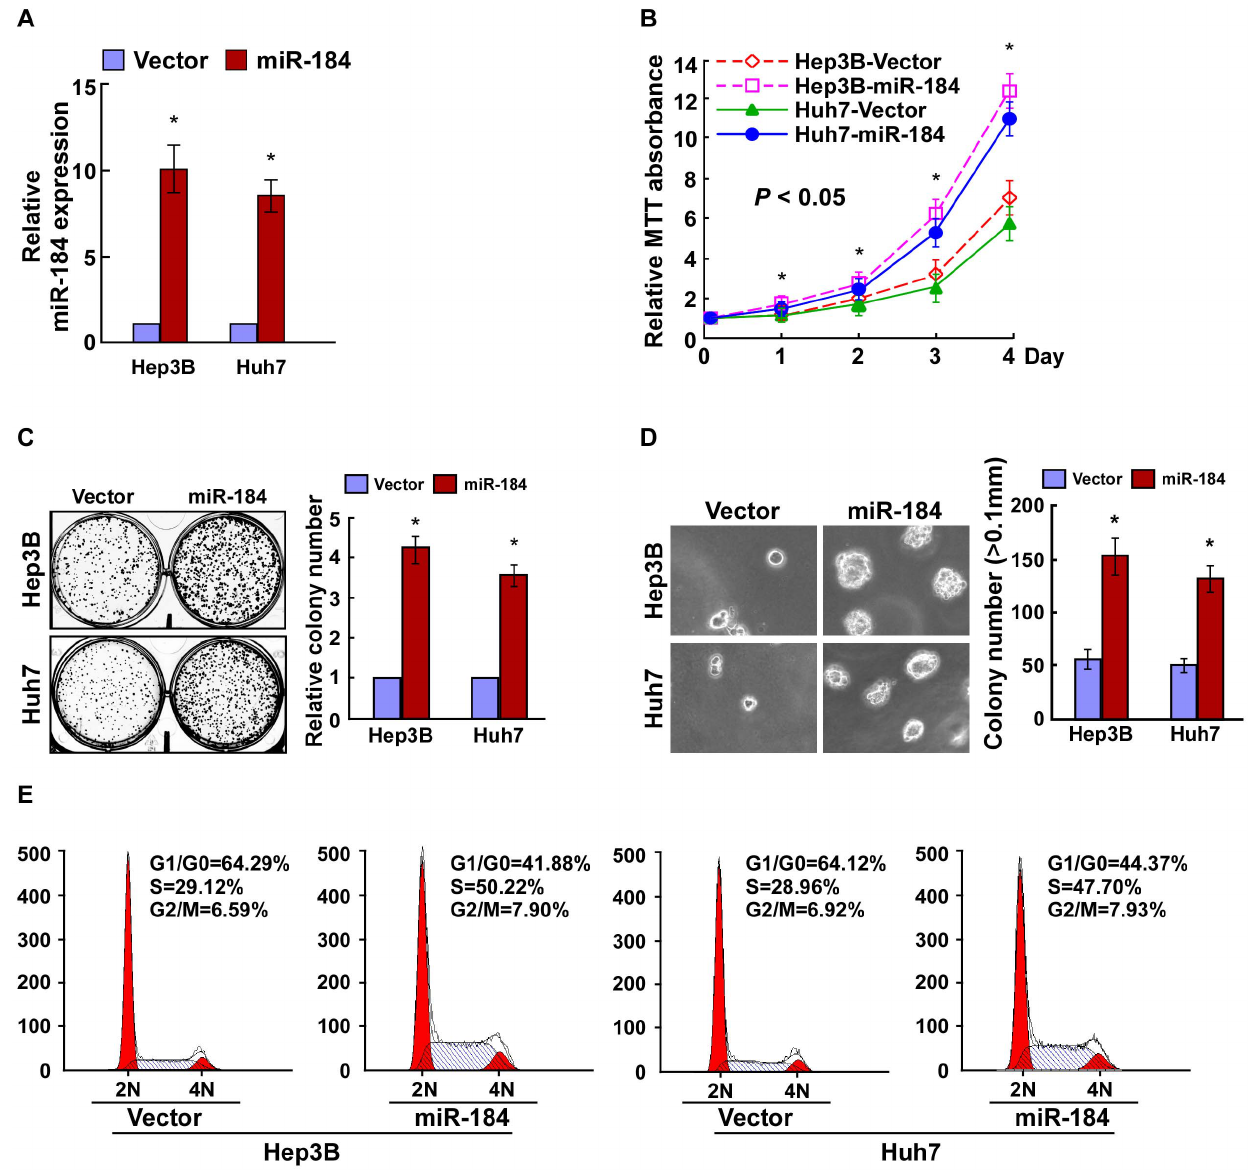
Figure 2. Ectopic miR-184 promotes the proliferation of HCC cells. A . Real-time PCR analysis of miR-184 expression in Hep3B and Huh7 cells stably overexpressing miR-184. B . Effects of ectopic miR-184 on the proliferation of the indicated HCC cell lines, as analyzed by the MTT assay. C . Representative micrographs (left) and quantifications (right) of crystal violet stained cell colonies formed by the indicated HCC cell lines, 10 days after inoculation. D . Effects of ectopic miR-184 on the tumorigenicity of the indicated HCC cell lines, as determined by anchorage-independent growth ability assay. Colonies larger than 0.1 mm were scored. E . Effects of ectopic miR-184 on the cell cycle progression of the indicated HCC cells, as measured by flow cytometry analysis. Each bar represents the mean 6 SD of three independent experiments. * P , 0.05. doi:10.1371/journal.pone.0088796.g002 for 10 seconds, primer annealing at 60 u C for 20 seconds, and primer extension at 70 u C for 5 seconds. GAPDH reverse: 3 9 - AGAGGCAGGGATGATGTTCTG -5 9 . Western Blotting Western blotting was performed according to a previously reported method [26]. The membranes were probed with polyclonal rabbit antibodies, anti-SOX7 ( # ab80331, 1:500; Abcam, Cambridge, MA, USA), anti-c-Myc ( # 9402), anti- CyclinD1 ( # 2978), anti-Rb ( # 9313) and anti-phosphorylated Rb ( # 9306; 1:1,000; Cell Signaling, Danvers, MA, USA). The